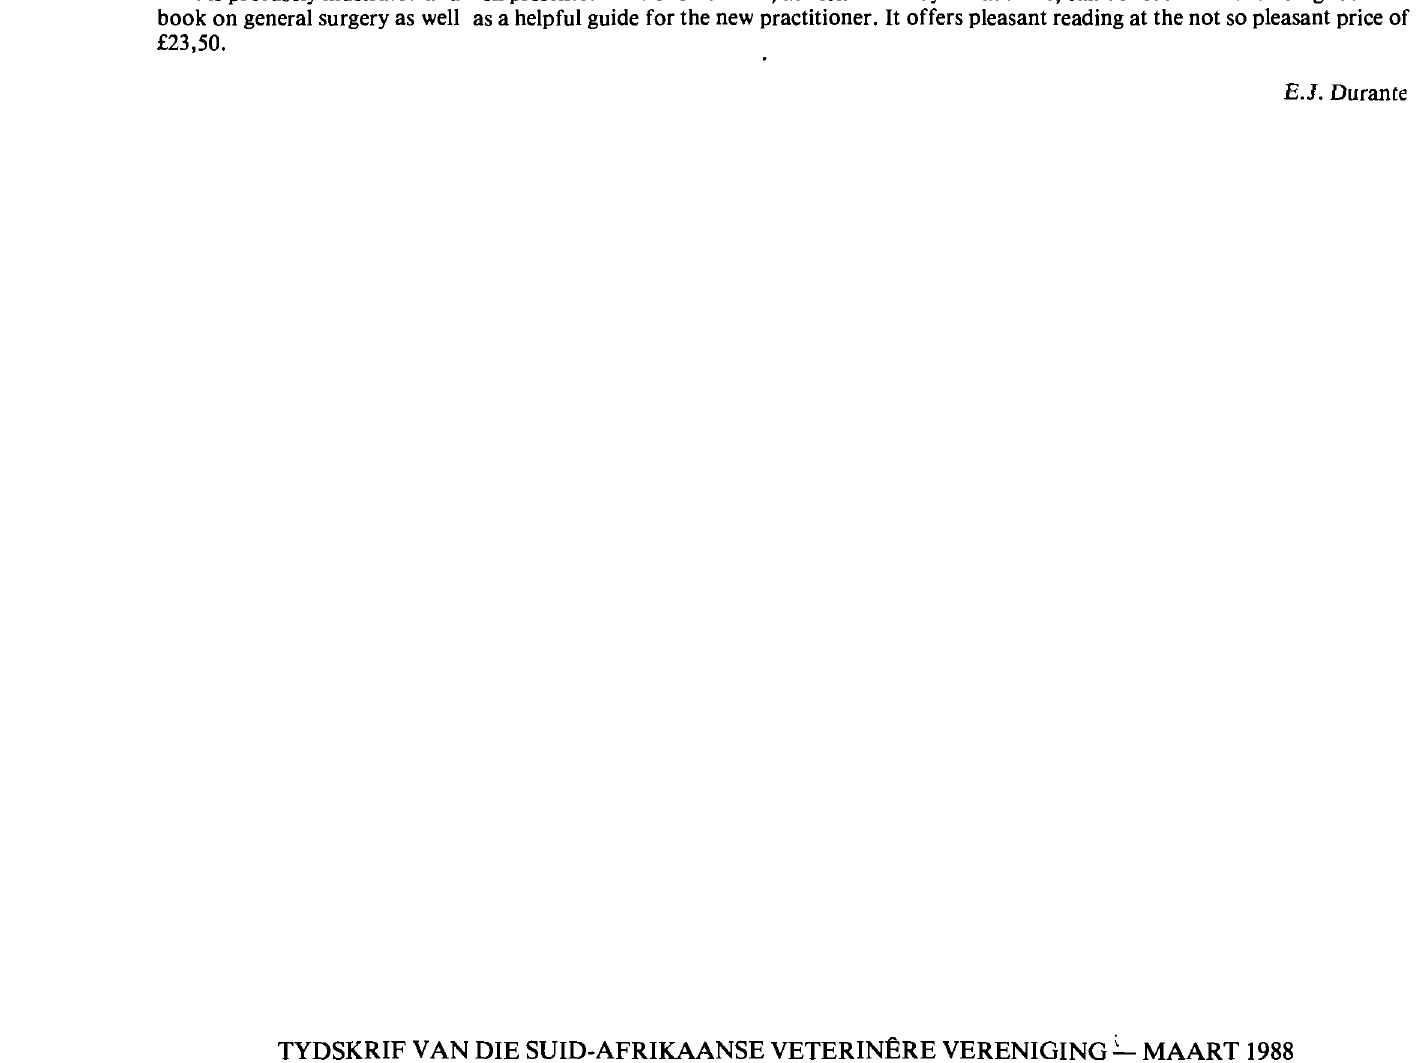
TYDSKRIF VAN DIE SUID-AFRlKAANSE VETERINERE VERENIGING!:...... MAART 1988 © South African Veterinary